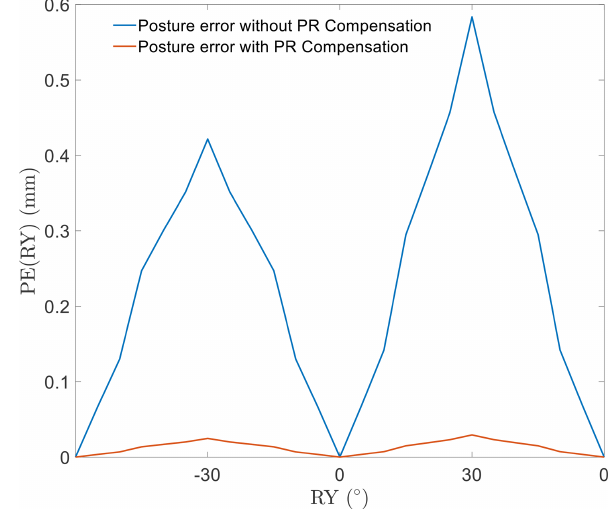
Figure 9. Comparison of posture errors in rotational motion around y